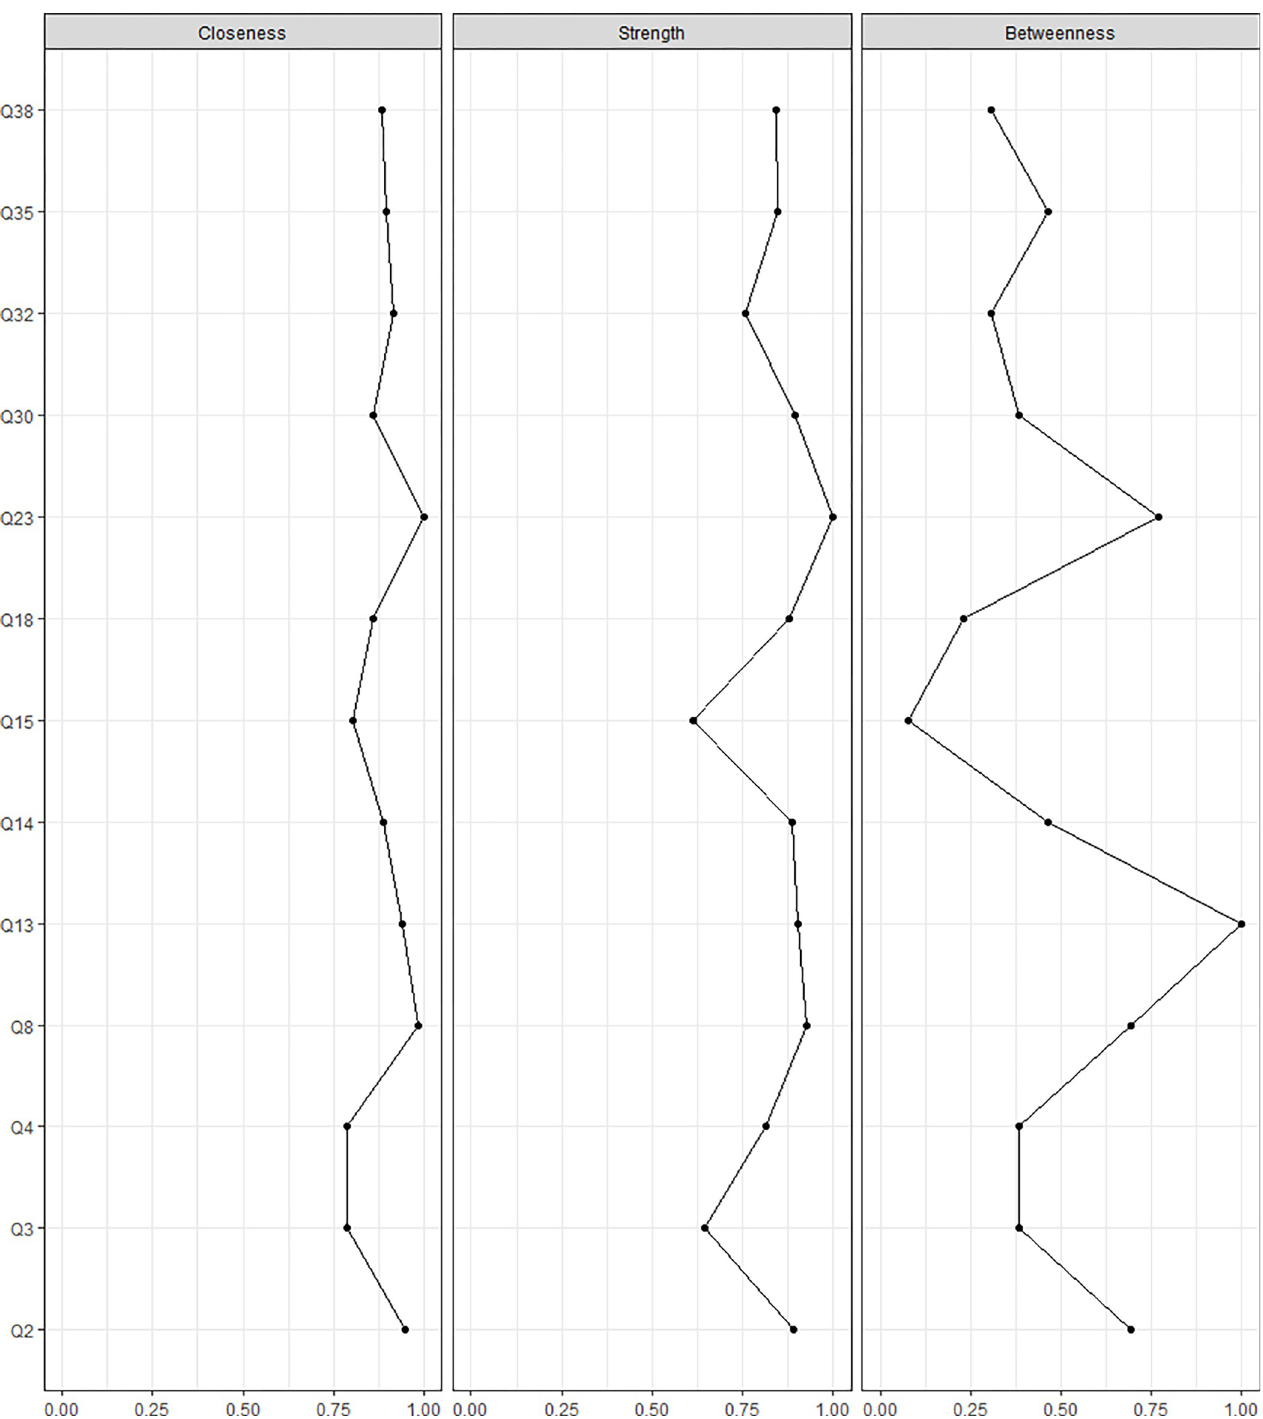
Fig 4. Centrality measures of Closeness, Strength, and Betweenness of each node in the network. Centrality value of 0 indicates no importance and 1 indicates maximal importance.